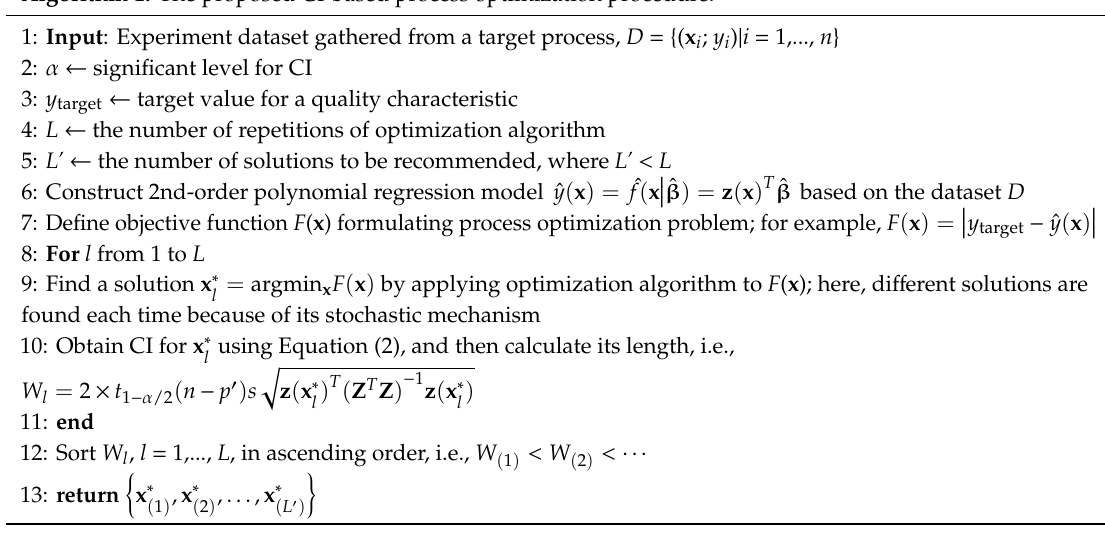
Algorithm 1. The proposed CI-based process optimization